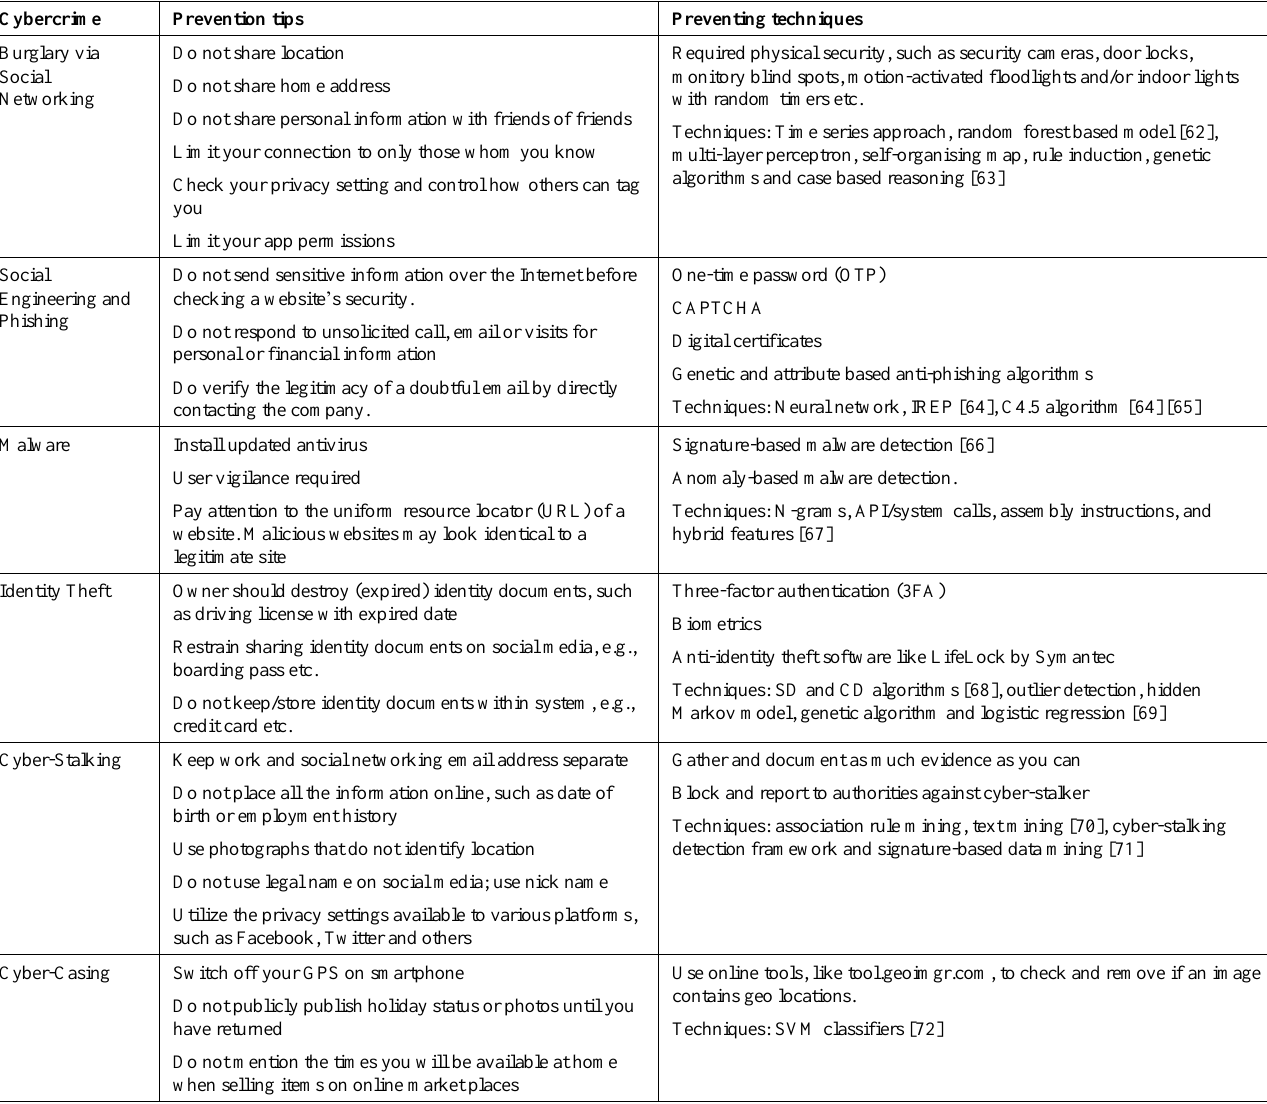
TABLE II R ECOMMENDATIONS AND T ECHNIQUES FOR C YBERCRIME P